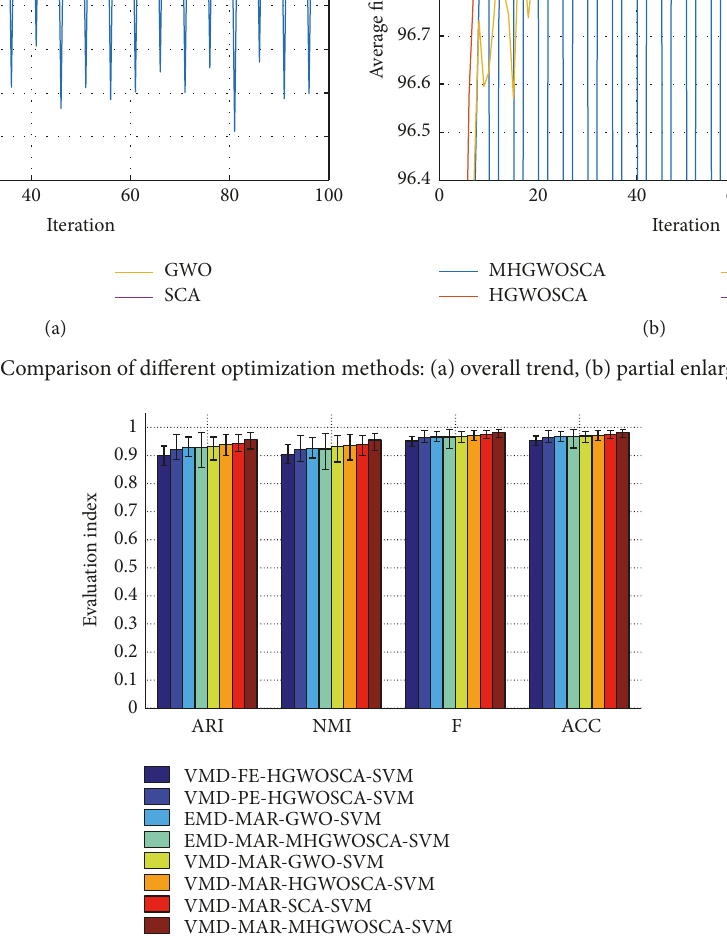
Figure 10: Comparison of evaluation values for different